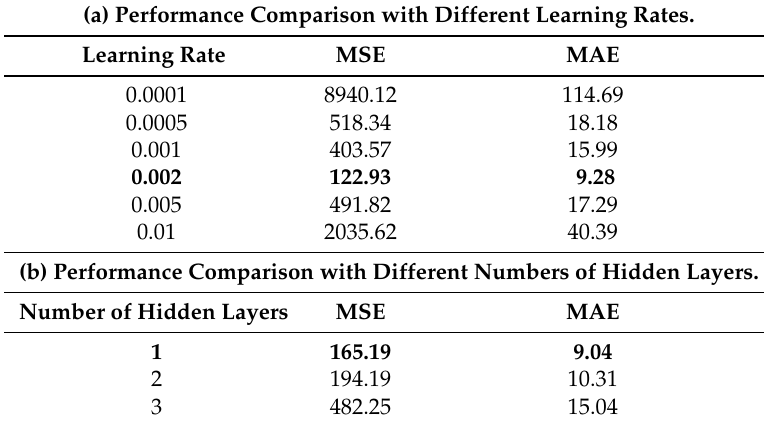
Table 4. Influence of the learning rate and the number of